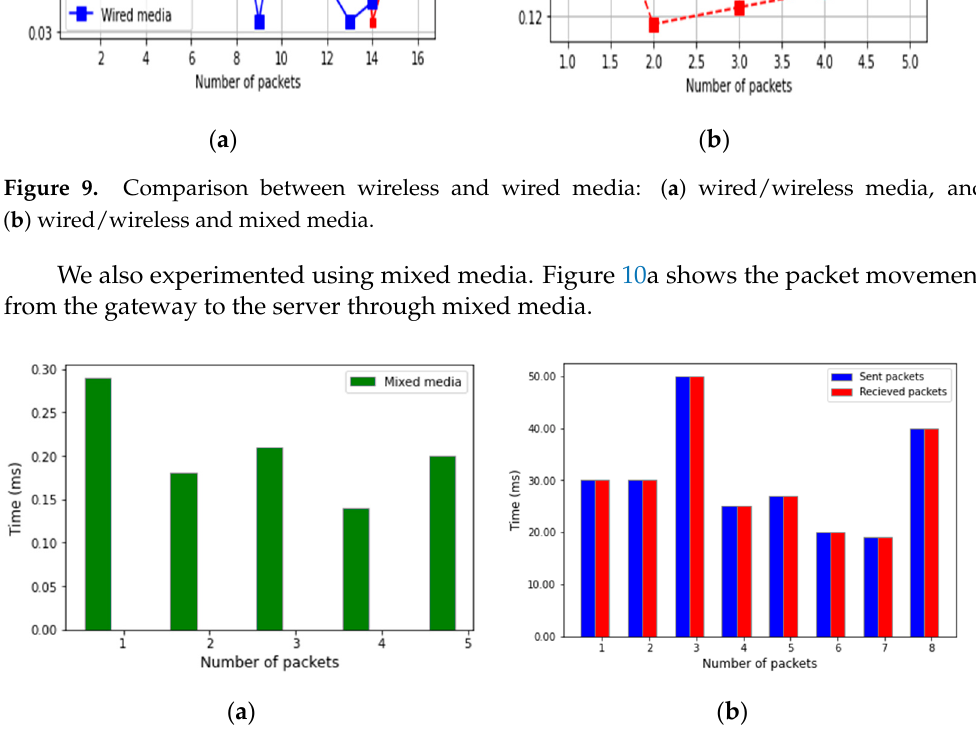
Figure 10. Comparison between packets sent/received and mixed media: ( a ) mixed media, and ( b ) sent/received packets.